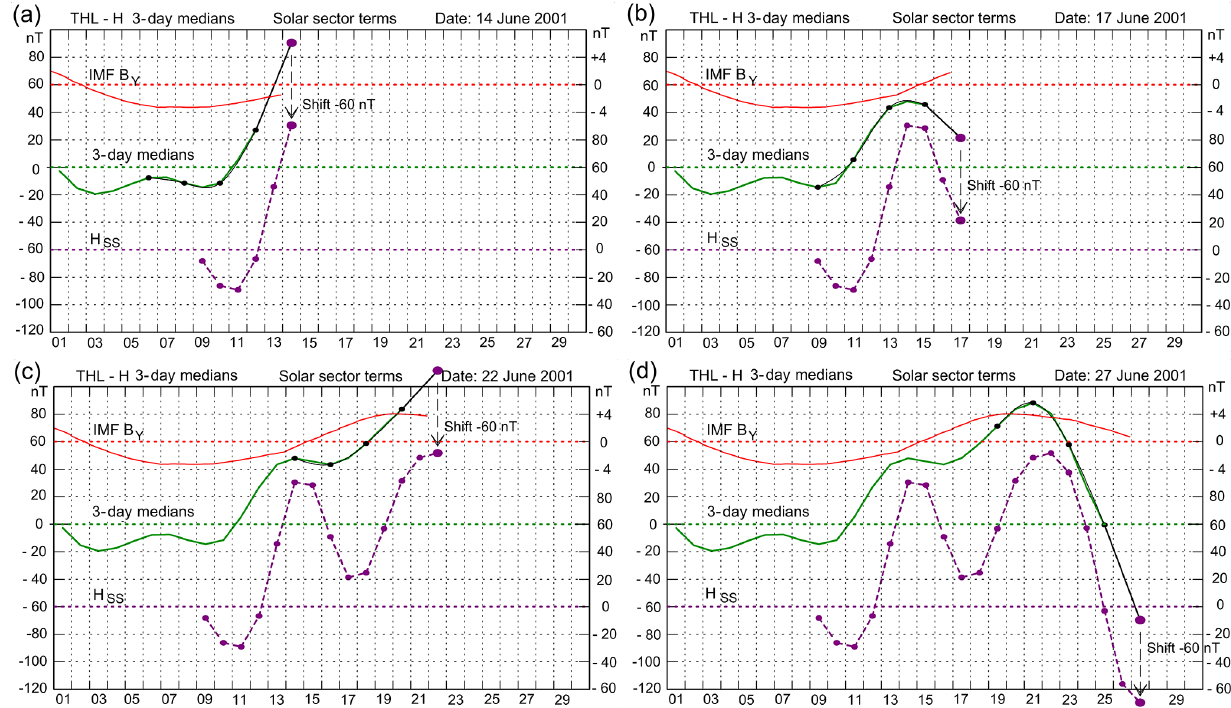
Figure 3. (a) Calculation of H SS from 3-day median values (green curve), based on data available up to and including 13 June (from Fig. 6b of J&T2011), using cubic spline interpolation (black line) on 3-day medians between 6 and 12 June (dots on green curve) and extrapolation to define H SS = 91nT on 14 June (large black dot). Resulting H SS values for June (so far) are displaced 60nT downward and connected by a dashed line using the lower right scale. (b) cubic spline interpolation on 3-day median samples between 9 and 15 June to define H SS = 21nT on 17 June. (c) cubic spline interpolation on samples between 14 and 20 June to define H SS = 112nT on 22 June. (d) Cubic spline interpolation between 19 and 25 June to define H SS = − 70nT on 27 June. Smoothed IMF B Y values are displayed at the top of the diagrams using the upper right